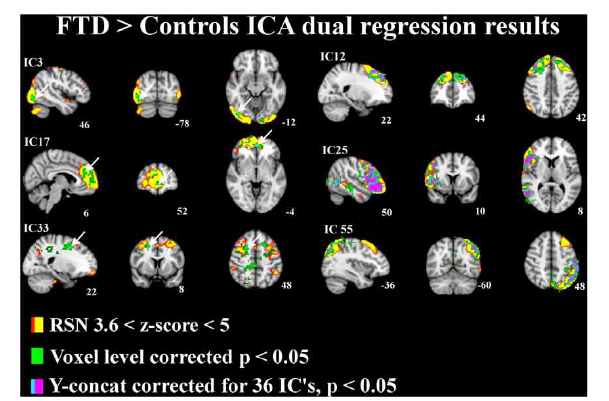
FIGURE 2 | Independent components (IC) with significant increase in functional connectivity in patients with bvFTD. The differences in resting state networks corrected for multiple comparison at voxel level in green and for y-concatenation correction for including all RSNs in lilac-blue, threshold p < 0 . 05. The differences between groups are also adjusted for gray matter differences. The involved RSN is presented in red-yellow color encoding with (3.6 < z -score < 6) threshold. Arrows in ICs 3, 17, and 33 indicate the y-concatenated results.